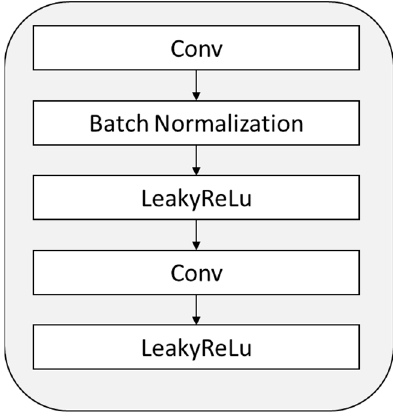
Figure 14. Structural diagram of residual block.